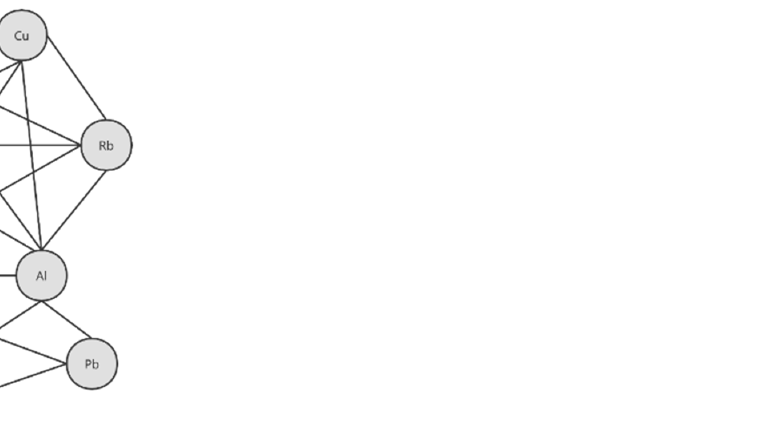
Figure 4. Toxic and essential trace elements’ correlation network in maternal plasma of pregnant women.